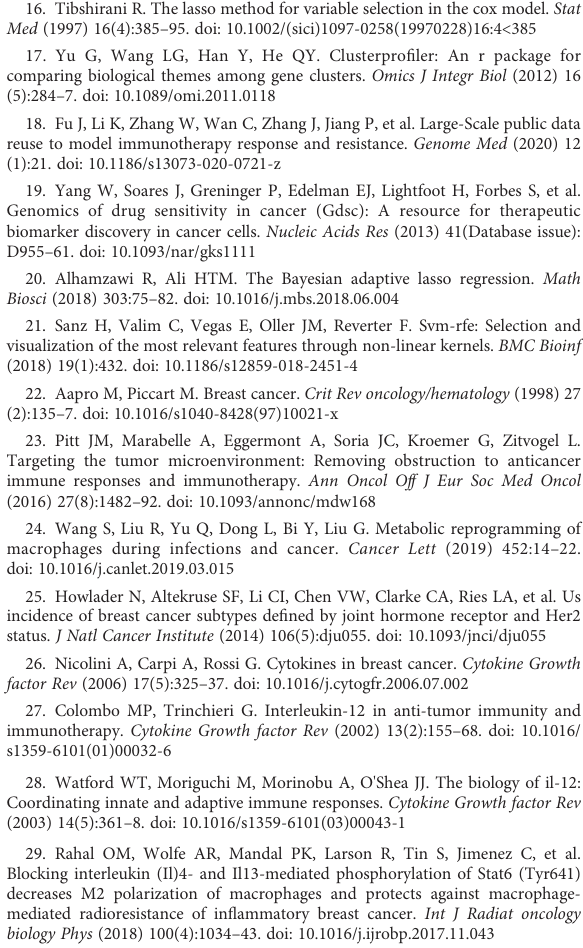
SUPPLEMENTARY FIGURE 1 The fl owchart of the whole study. SUPPLEMENTARY FIGURE 2 Exploration of the underlying biological difference between different age and risk patients. (A) GSEA was performed in ≤ 60- and >60-year-old patients. (B) GO and KEGG analysis of high- and low-risk